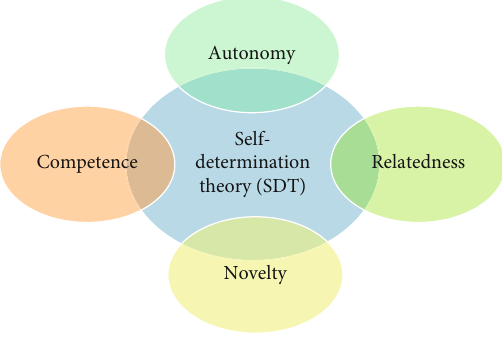
Figure 1: Psychological